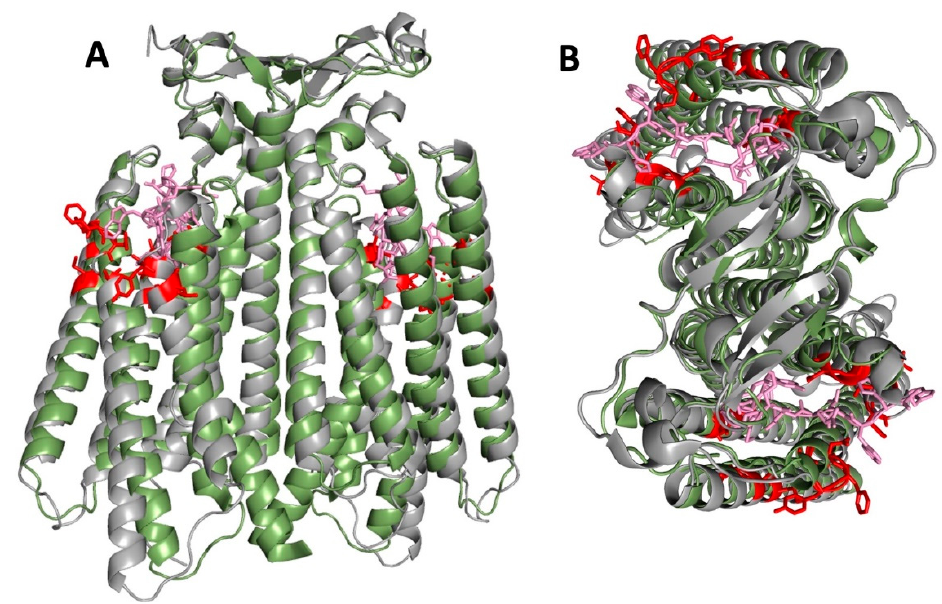
Figure 10. Locations of sites of dominant-negative mutations in Ste2p. ( A ) Sites of substitutions with dominant-negative effects are shown in red in stick representation mapped onto the ligand-free structure of Ste2p (PDB Code: 7QB9) shown in grey), viewed in a direction parallel to the membrane. The structure of the Ste2p in the α -factor-bound receptor-G protein complex is shown in olive green. Bound α -factor is shown as pink sticks. ( B ) Sites of dominant-negative mutations of Ste2p shown in a view from the extracellular side of the membrane. Coloring used is the same as that in panel ( A ).